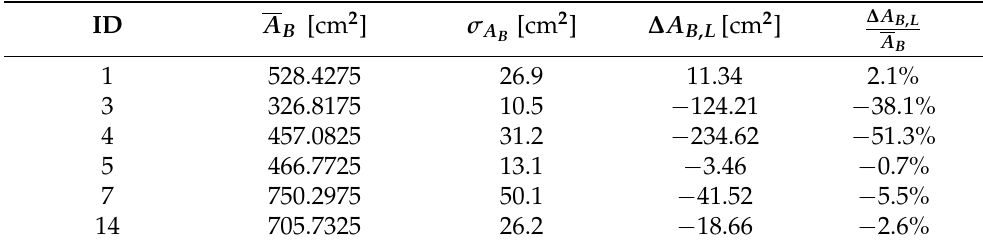
Table 5. Averaged leaf areas A B over the entire time series of plant p 1_ l , acquired by the MSS as well as differences ∆ A B , L between the B-spline based leaf area determination and the results of the leaf area meter.